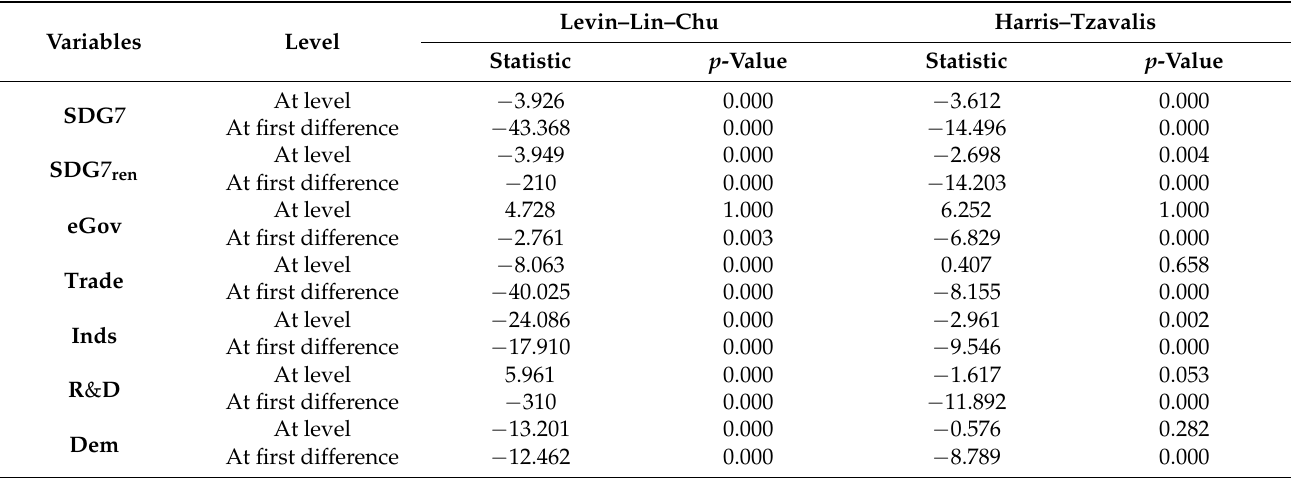
Table 3. The empirical results of a stationarity check using the unit root test cross-sectional depen- dence tests.